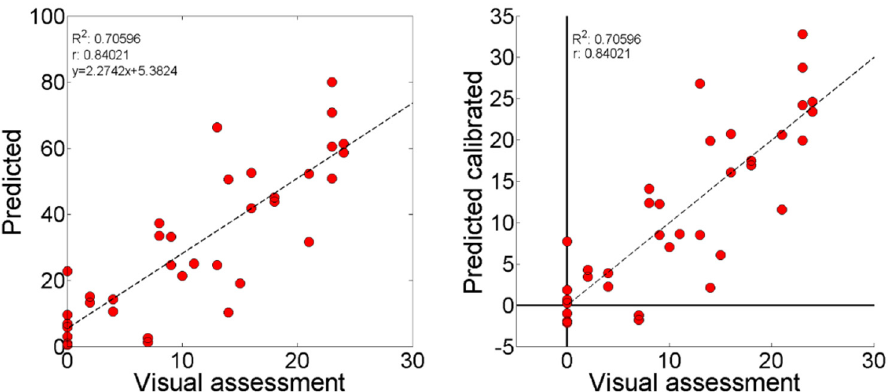
Figure 6. Scatter plot of the relation between visual assessment and predicted disease ratios for yellow rust on 23 May 2018 before ( left ) and after the application of a linear calibration model ( right ). The calibration model had the purpose of compensating for scale differences in the prediction values.